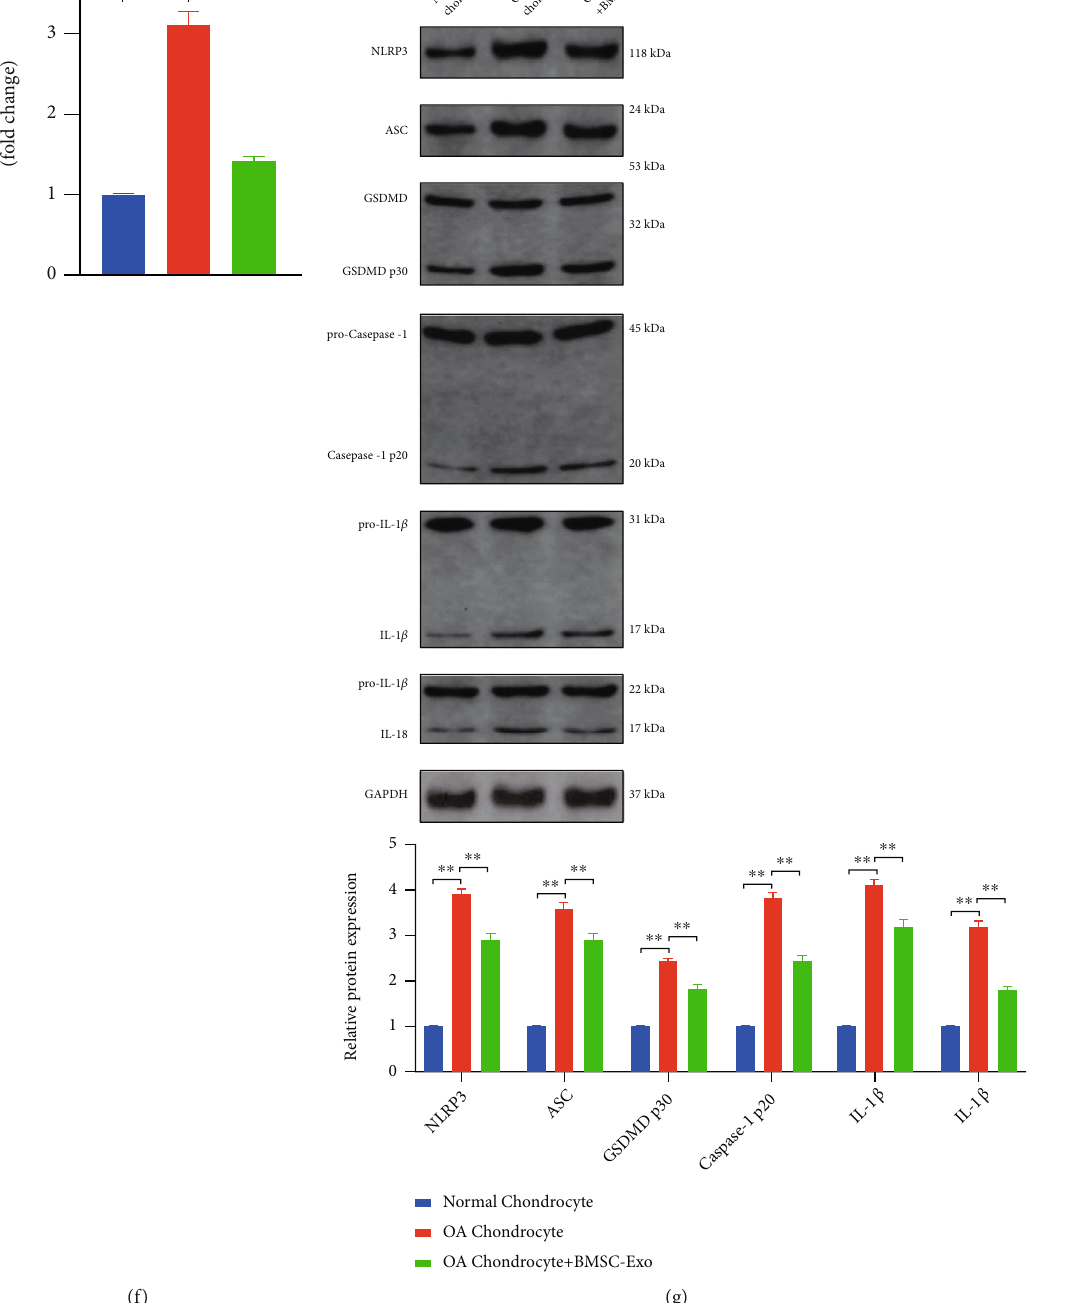
Figure 2: BMSC-Exos inhibit the pyroptosis and maintain chondrocyte homeostasis of OA chondrocytes. (a) Incubation of BMSC-Exos reversed the slow proliferation of chondrocytes induced by OA; (b) incubation of BMSC-Exos reversed the reduction of chondrocyte migration induced by OA; (c) incubation of BMSC-Exos reversed the reduction of chondrogenic characteristic genes (COL2A1, SOX9, Agg, and Prg4) mRNA expression in chondrocytes induced by OA; (d) incubation of BMSC-Exos inhibited the increase of proin fl ammatory cytokines in chondrocyte culture medium induced by OA; (e) immuno fl uorescence results showed that BMSC-Exos incubation inhibited the OA-induced increased distribution of GSDMD and cl-Caspase-1 in chondrocytes; (f) BMSC-Exos incubation inhibited the OA-induced increased of Caspase-1 activity in chondrocytes; (g) results of Western blot showed that BMSC-Exos incubation inhibited the OA-induced increased expression of pyroptosis-related proteins (NLRP3, ASC, GSDMD, Caspase-1, IL-1 β , and IL-18) in chondrocytes; ∗∗ P < 0 : 01